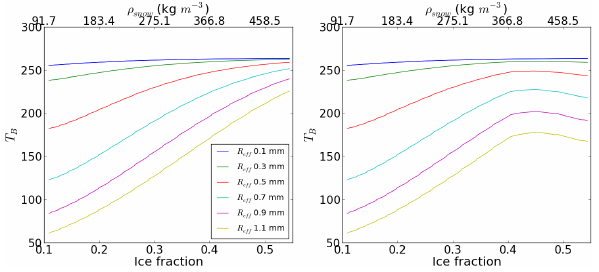
Figure 4. T B without (left) and with the bridging implementation (right) at 37GHz (V-pol) for different R eff ( T snow = 260K, T soil = 270K and SD =